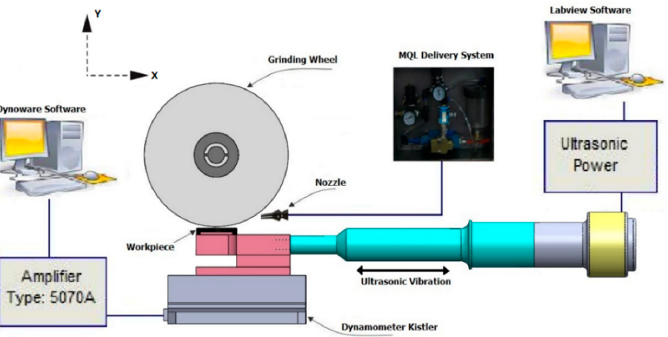
Figure 3. Grinding experiments diagram.